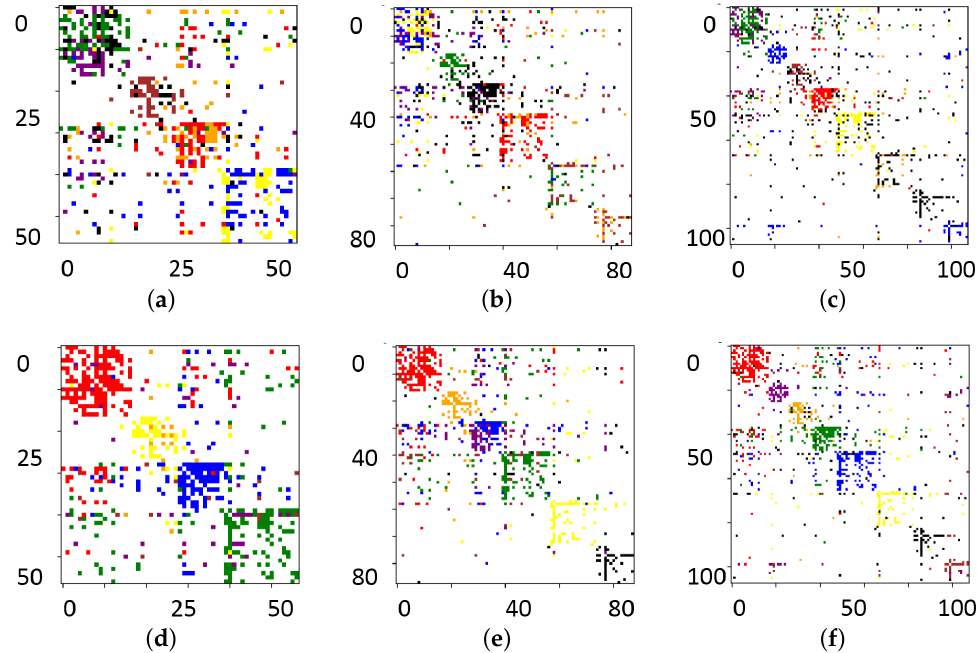
Figure 3. ( a – c ) The states after 10 times training of the class assignments in calculation, corresponding to Networks 1–3 in Section 3. ( d – f ) The states after 100 times training. The horizontal and vertical coordinates are the numbers of the nodes in the network, where different nodes represent different cities. If there are links between two nodes, there is a bright spot at the point with the corresponding horizontal and vertical coordinate. The different colors indicate the different classifications of